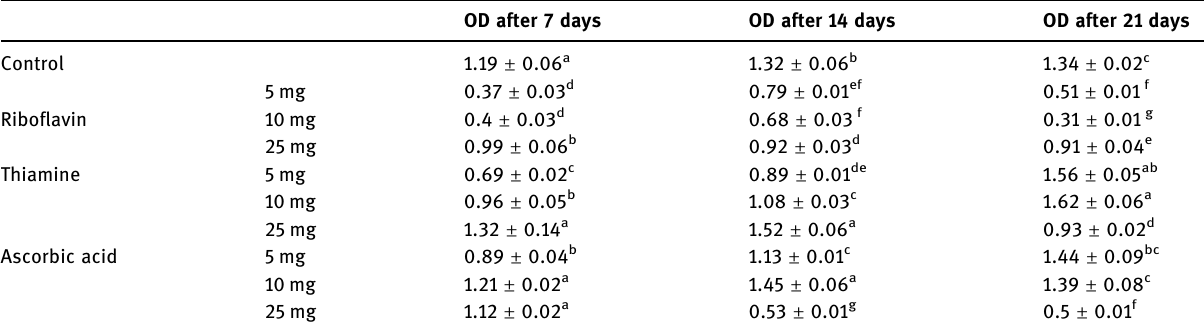
Data are presented as mean ± SEM ( n = 3 ) . Values having di ff erent superscript letters within the same columns are signi fi cantly di ff erent ( p < 0.05 ) .